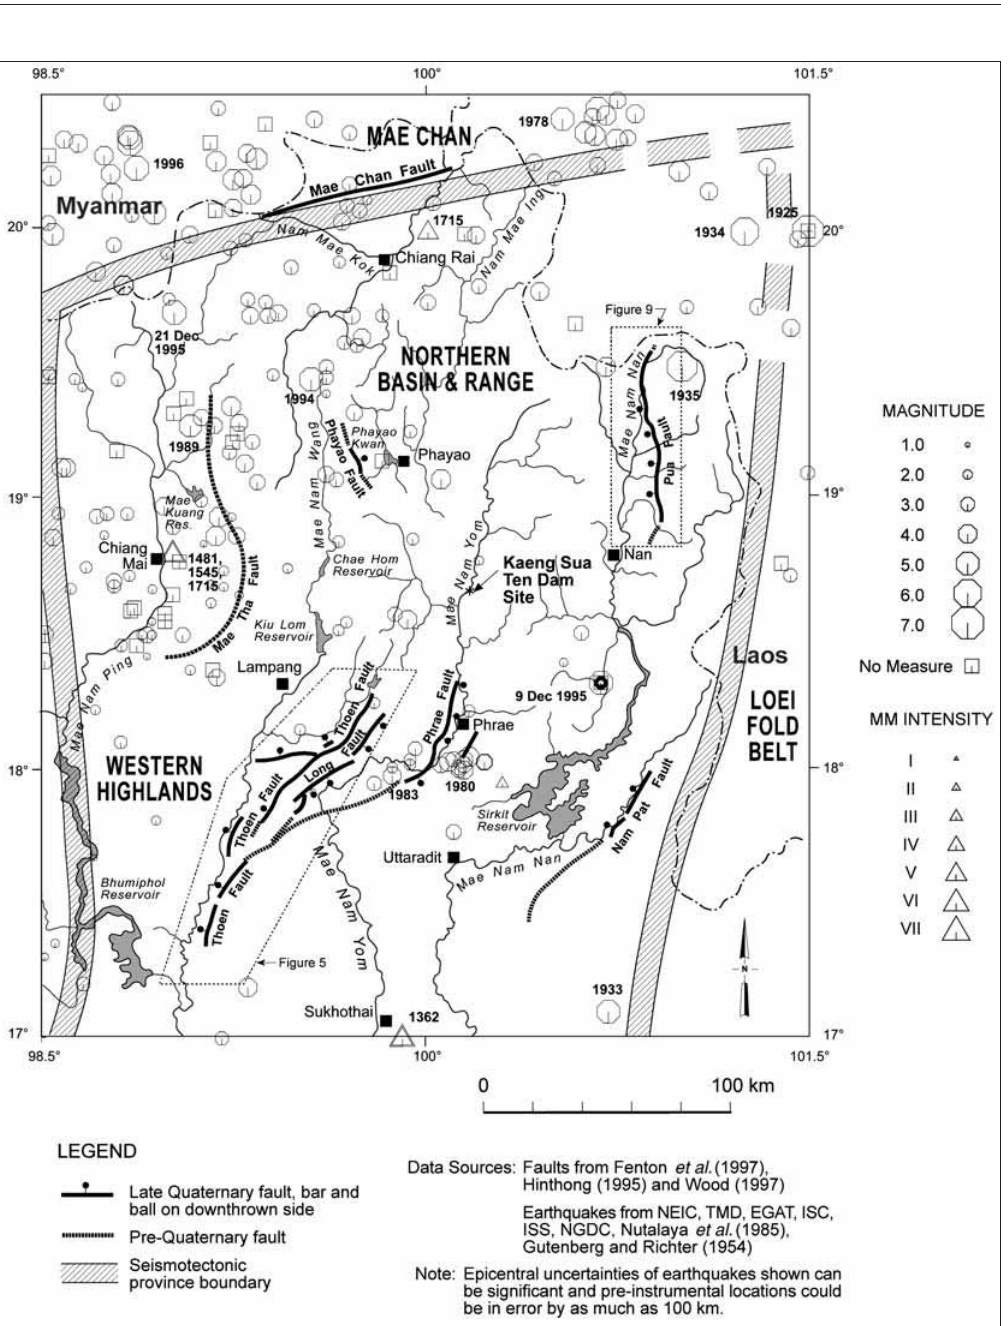
Fig. 3. Late Cenozoic faults and historical seismicity (1362 to 1996) of the Northern Basin and Range seis- motectonic province. Figure modified from Bott et al.